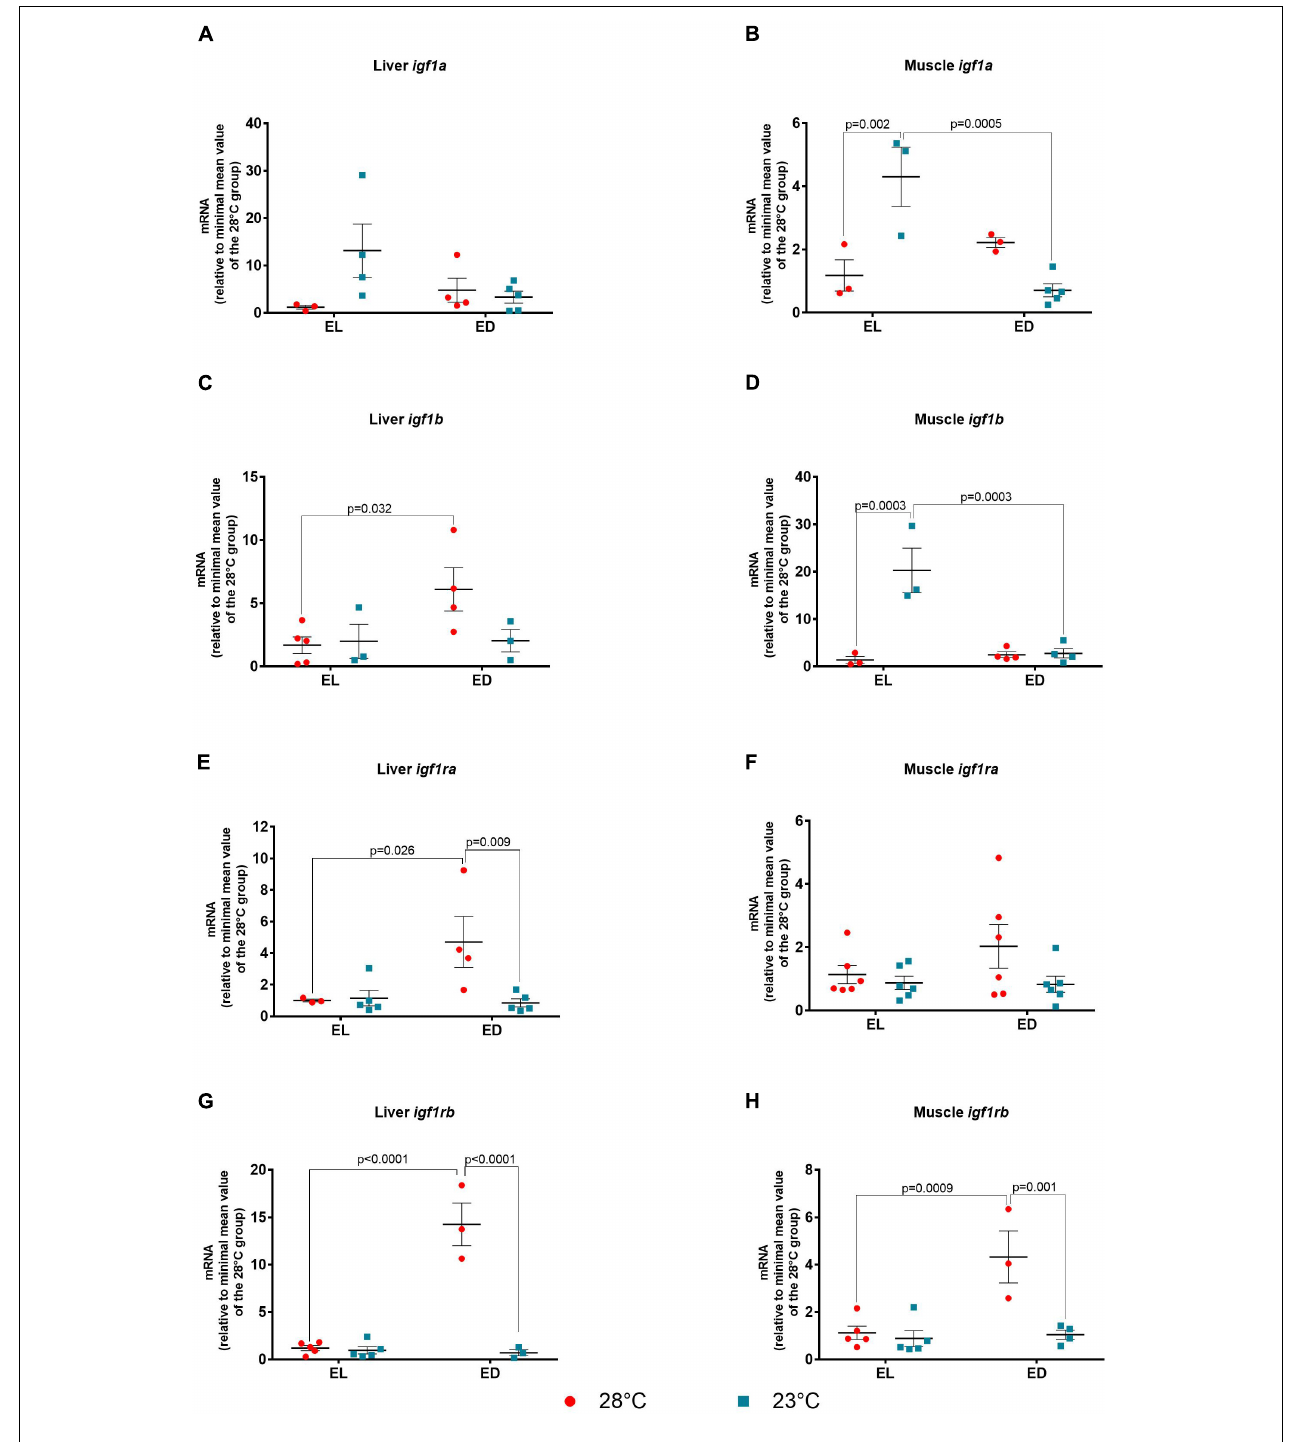
FIGURE 3 | Early light (EL) and early dark (ED) gene expression of insulin-like factors ( igf1a and igf1b ), and their receptors ( igf1ra and igf1rb ) in adult Danio rerio . (A) Liver igf1a ; (B) muscle igf1a ; (C) liver igf1b ; (D) muscle igf1b ; (E) liver igf1ra ; (F) muscle igf1ra ; (G) liver igf1rb ; (H) muscle igf1rb. The gene expression was normalized by the 18S rRNA and expressed relative to the lowest mean of the control temperature group. The values are expressed as mean ± SEM. n = 3–6 (pools of four animals each). Significant differences are shown when p < 0.05. Red symbol corresponds to 28 o C and blue symbol corresponds to 23 o C.